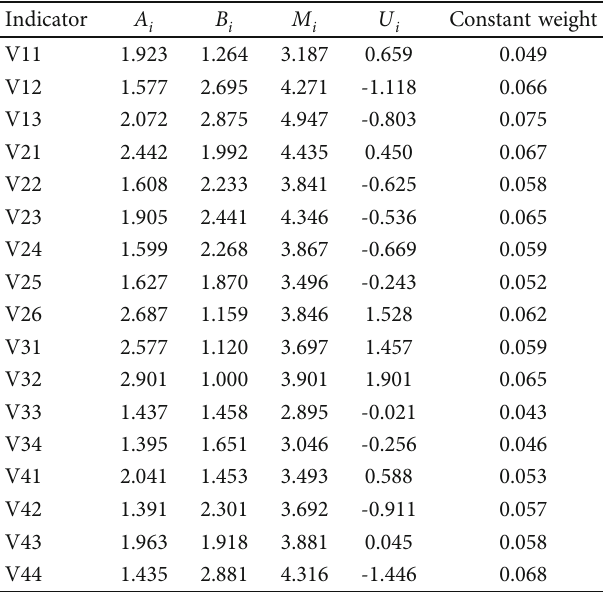
Table 4: Summary of the constant weight of each risk